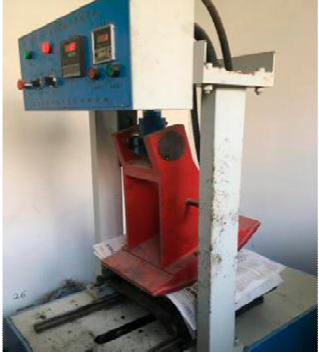
Figure 1. Rut board forming machine.